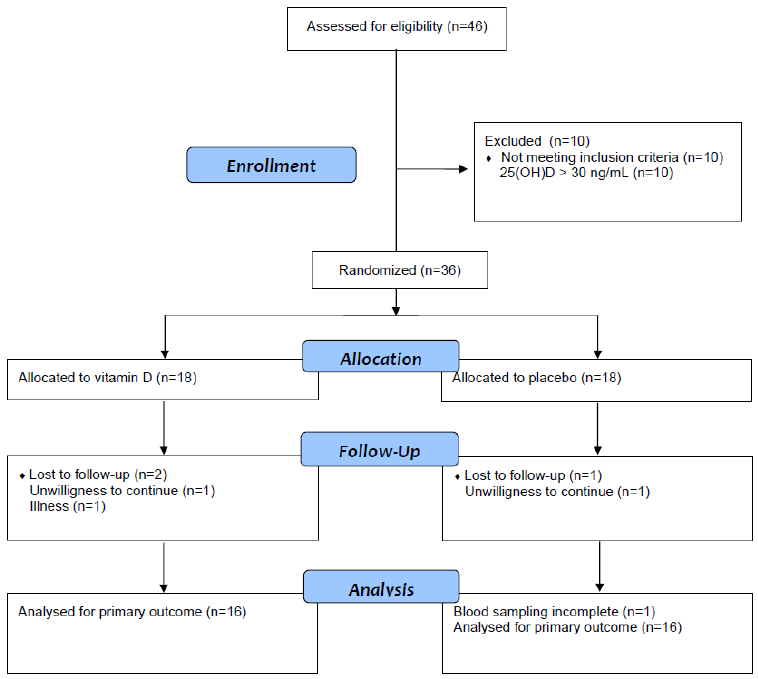
Figure 1. Participant flow chart. Table 1. Baseline characteristics of all randomized study